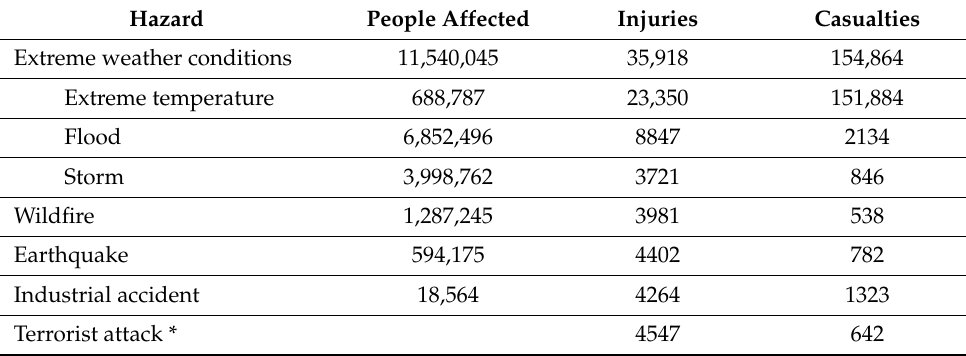
Table 1. Human consequences of selected disasters for the last 20 years in Europe. Sources: EM-DAT [1] and GTD [40]. Hazard People Affected Injuries Casualties Extreme weather conditions 11,540,045 35,918 Extreme temperature